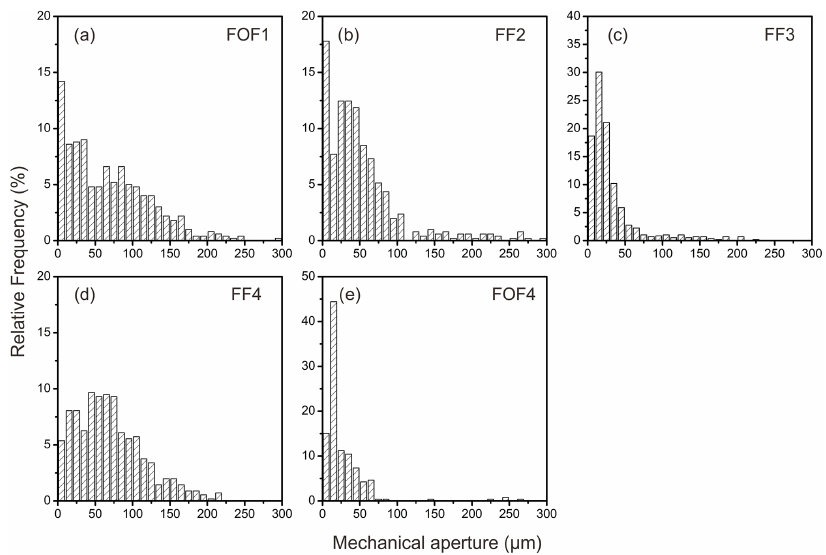
Figure 8. Frequency histograms showing the mechanical aperture distribution obtained from the 2D microscopic images of each sample.